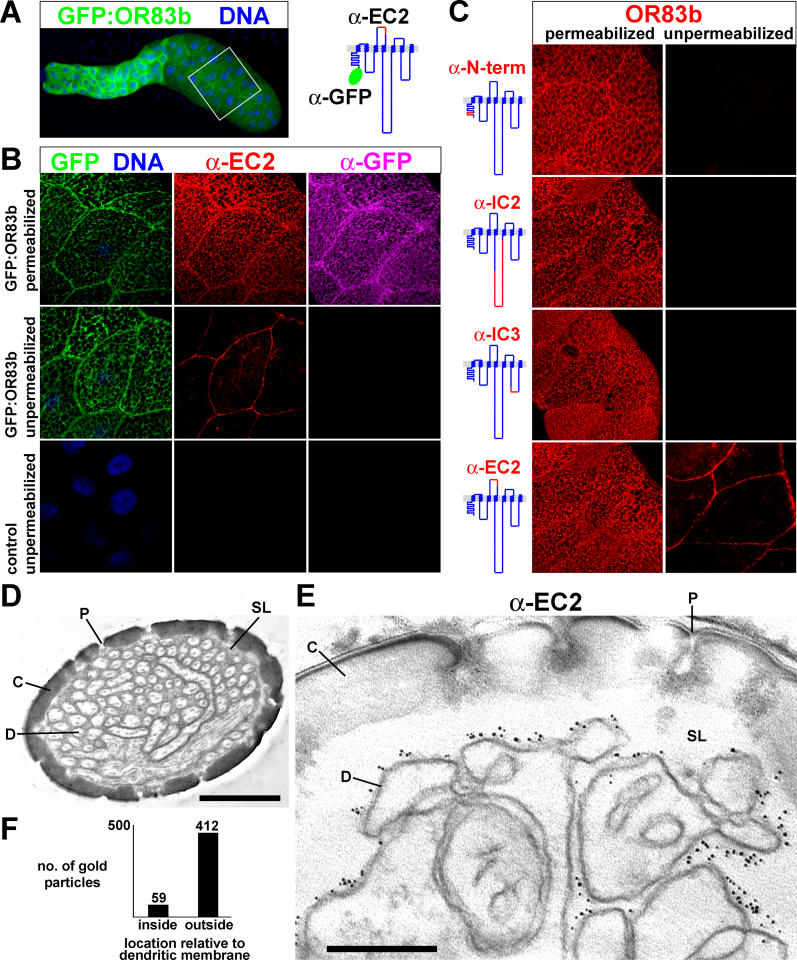
Probing OR83b Topology by Antibody Epitope Staining(A) Left panel: whole-mount view of a third instar larval salivary gland expressing GFP:OR83b (green) counterstained with DAPI (blue) to visualize the cell nuclei. Genotype in this and subsequent panels: AB1-Gal4/+;UAS-GFP:Or83b/+. The white box marks the approximate field of view of this tissue shown in all subsequent panels. Right bar graphic: snake plot of OR83b showing the predicted topological location of the N-terminal GFP epitope and the OR83b α-EC2 antibody epitope.(B) Immunostaining of GFP:OR83b (intrinsic fluorescence in green) in larval salivary gland cells with α-EC2 (red) and α-GFP (purple) when permeabilized (0.25% Triton X-100 detergent, top row) or unpermeabilized (no detergent, middle row). The cell membrane staining of OR83b α-EC2 under unpermeabilized conditions is not detected in control salivary glands (AB1-Gal4/+) (bottom). Images are single confocal sections of cells in a plane through or just above the cell nuclei (visualized with DAPI staining, blue).(C) Salivary glands expressing GFP:OR83b (AB1-Gal4/+;UAS-GFP:Or83b/+) were stained with antibodies against the epitopes, illustrated in red in the snake plots on the left, under permeabilized or unpermeabilized conditions. For clarity, only the red channel is shown. None of the antibodies stain control salivary glands under permeabilized conditions (unpublished data).(D) Horizontal section of an antennal sensillum viewed by conventional EM reveals cross-sections of dendritic membranes (scale bar = 1 μm). C, cuticle; P, pore; D, dendrite; SL, sensillum lymph.(E) ImmunoEM on a horizontal section of an antennal sensillum using OR83b α-EC2 and a secondary antibody conjugated to 5 nm colloidal gold reveals distribution of the EC2 epitope on the extracellular face of the dendritic membranes (scale bar = 200 nm).(F) Quantification of gold particle distribution scored from four sections obtained in two independent experiments.